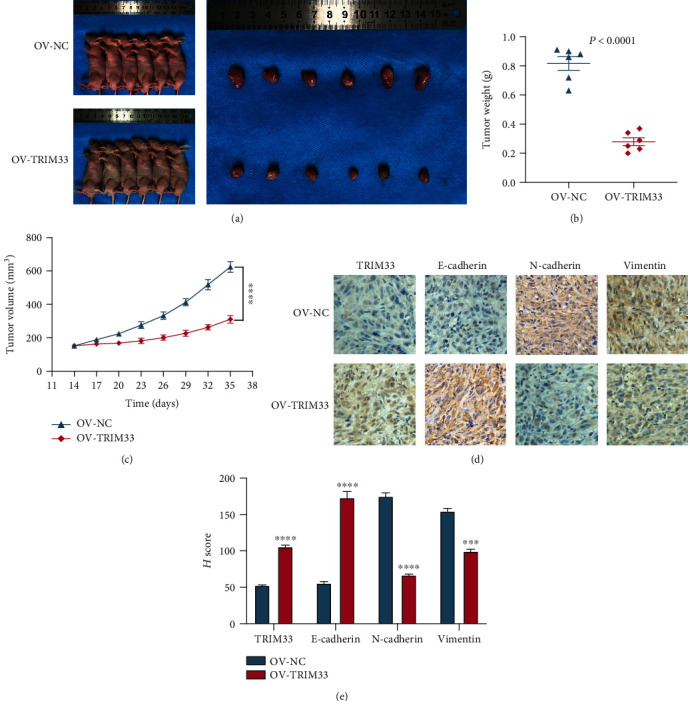
TRIM33 overexpression can inhibit tumor growth in vivo. (a) Pictures of nude mice and tumors. (b) Scatter plot of tumor weight between the OV-TRIM33 group and the OV-NC group. P < 0.0001. (c) Tumor volume measured every 3 days after the second week. (d, e) Immunohistochemistry staining for TRIM33, E-cadherin, N-cadherin, and vimentin. A histogram is used to display semiquantitative analysis results. ∗∗∗P < 0.001; ∗∗∗∗P < 0.0001.